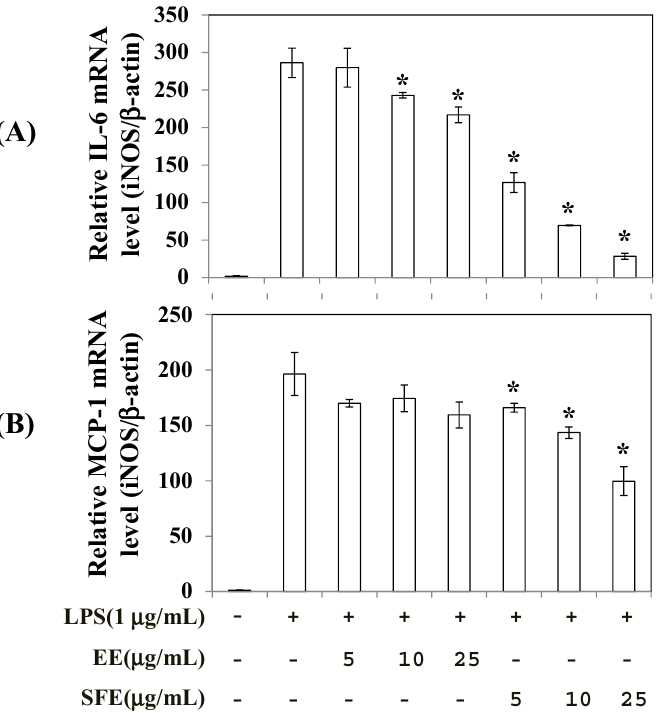
Figure 5. Effects of SFE (50 ◦ C, 400 bar, 3 h, and CO 2 flow rate of 60 mL/min) and EE (shaking incubation for 6 h at 60 ◦ C) on IL-6 and MCP-1 expression levels in RAW 264.7 cells. Total RNA was isolated and used to measure the expression levels of IL-6 ( A ) and MCP-1 ( B ) mRNA by quantitative real-time PCR. Data are presented as means ± SD ( n = 3). * p < 0.05 vs. LPS alone − treated group.